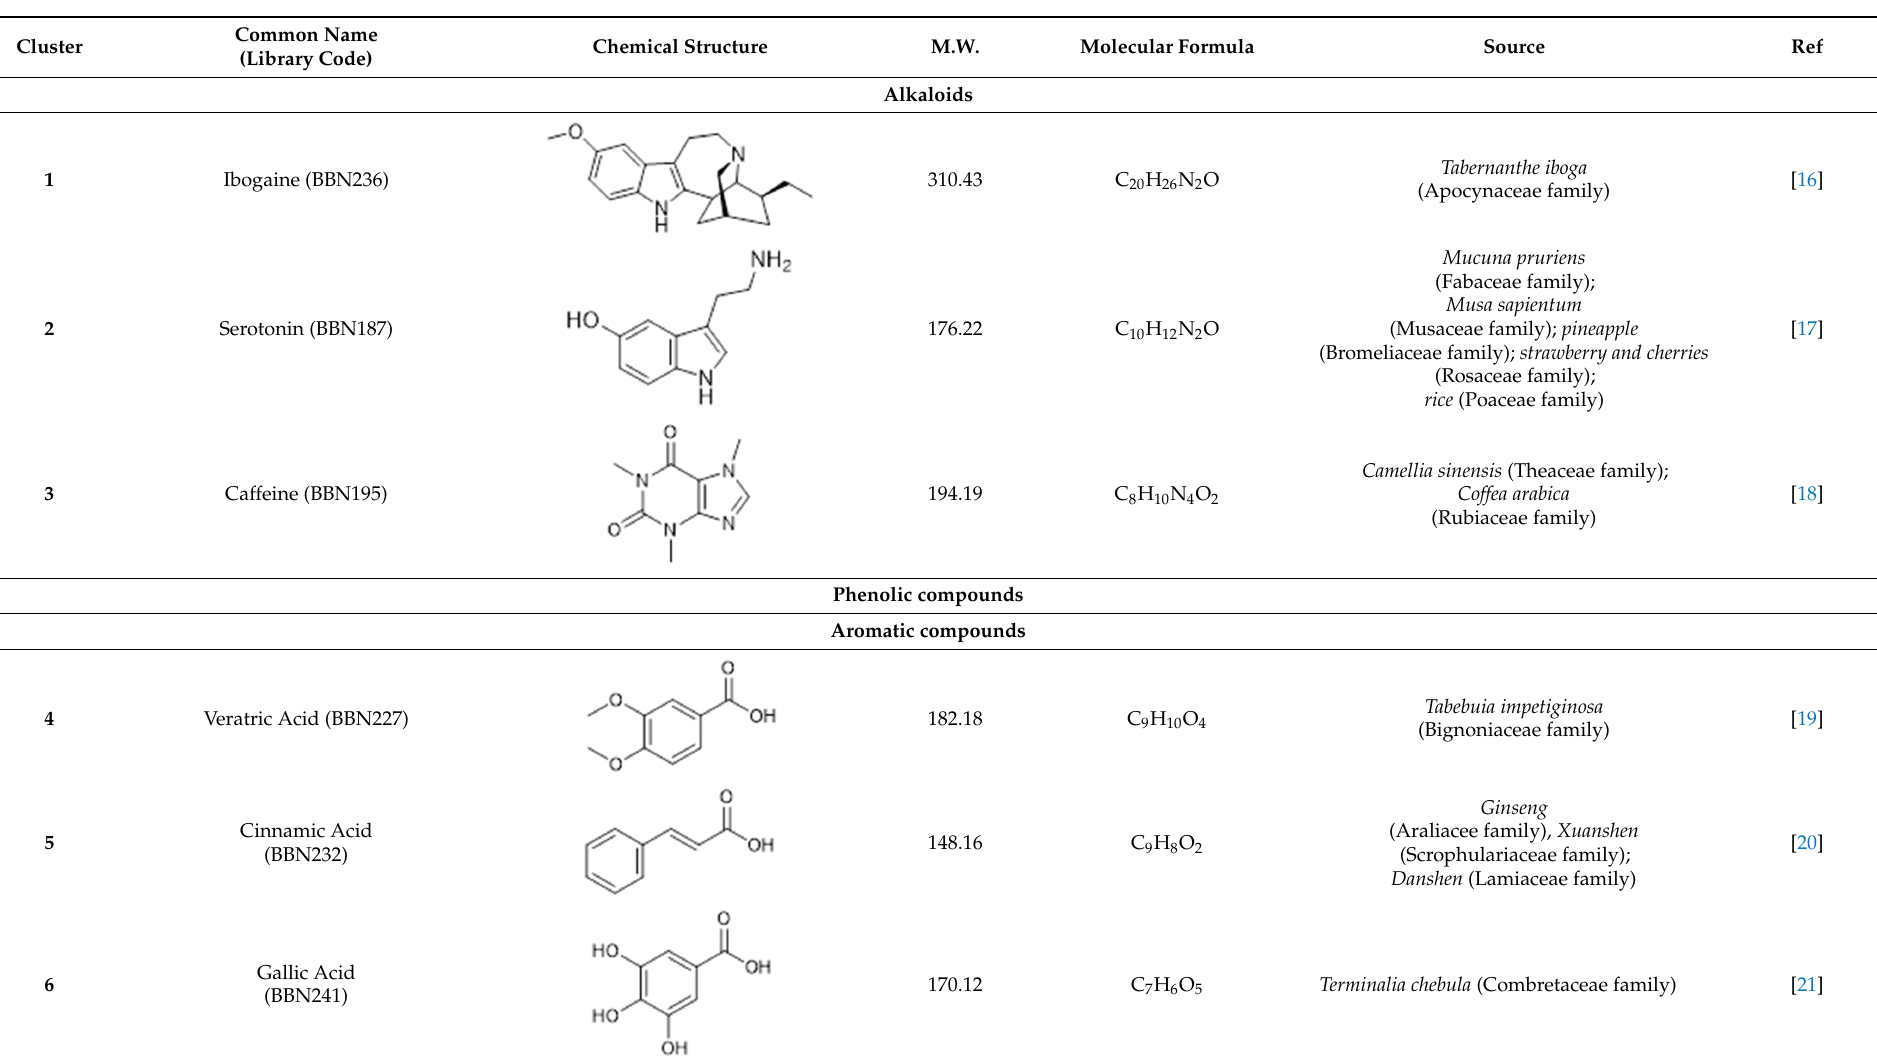
Table 1. List of the molecules tested in this work and their general features.